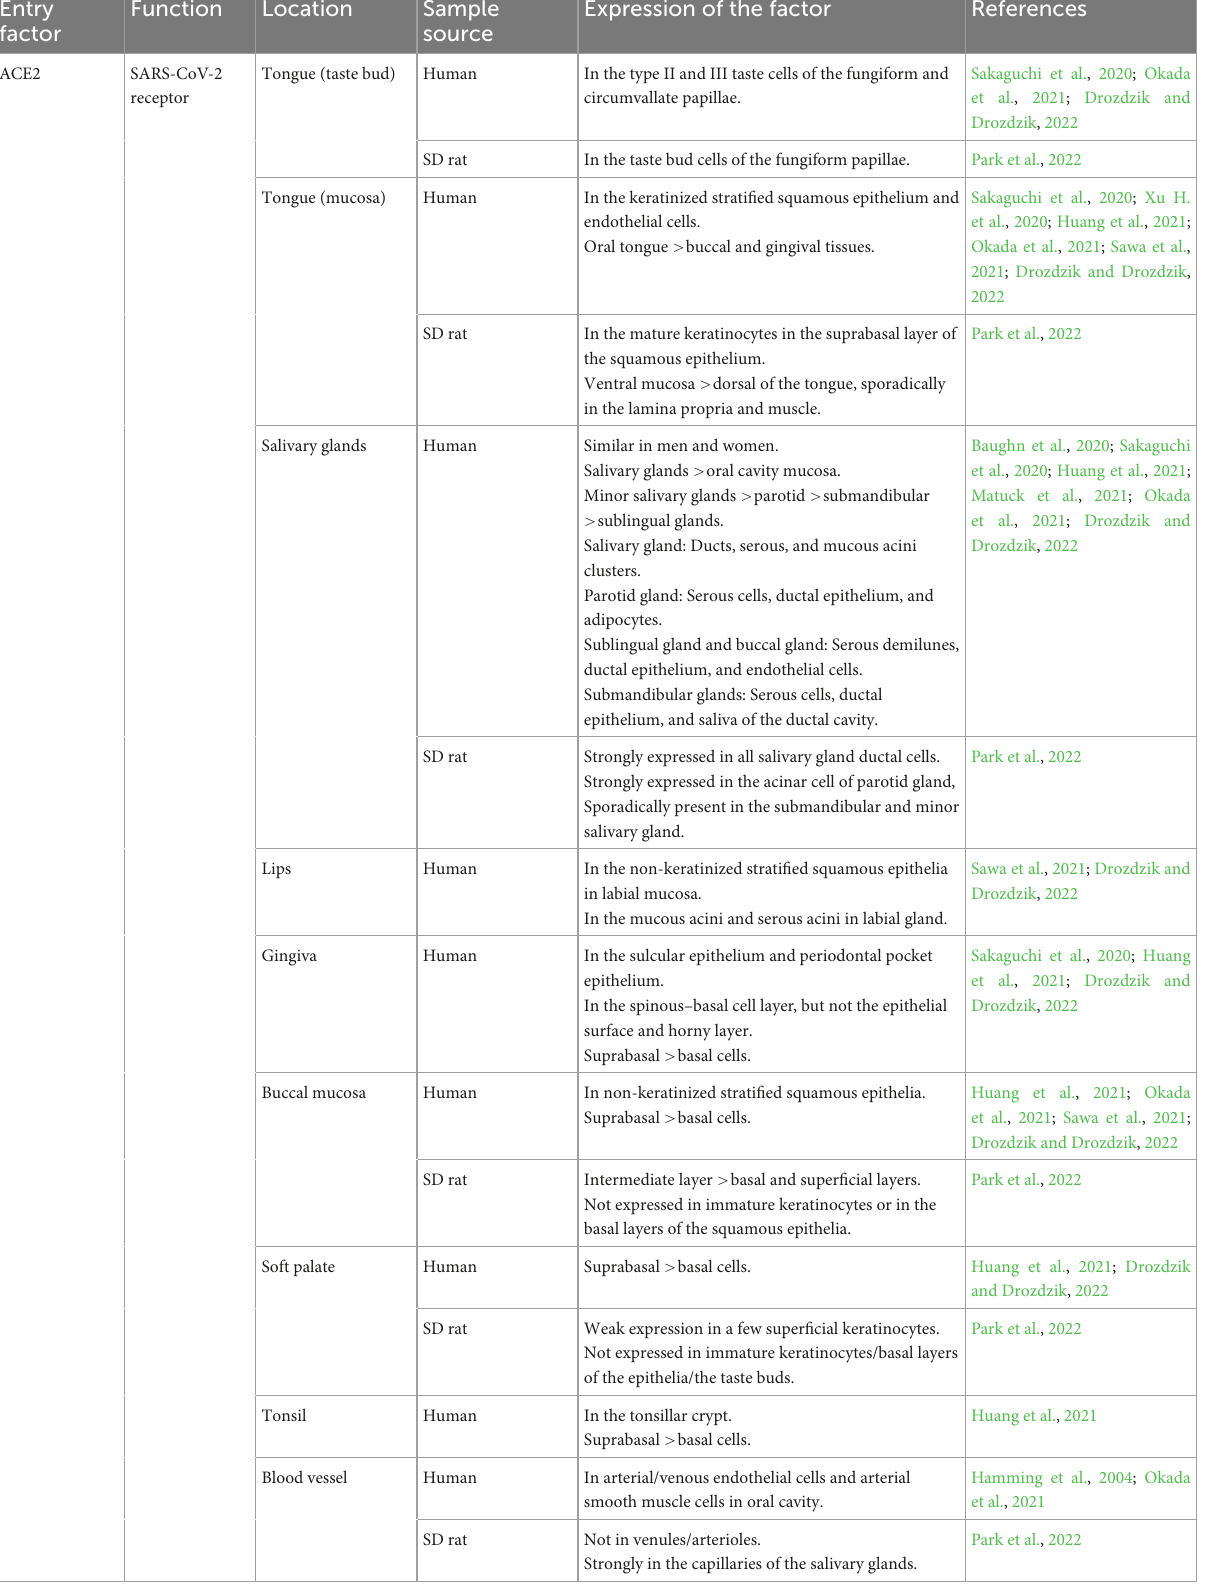
TABLE 1 The expression and function of SARS-CoV-2 entry factors in varying structures of oral